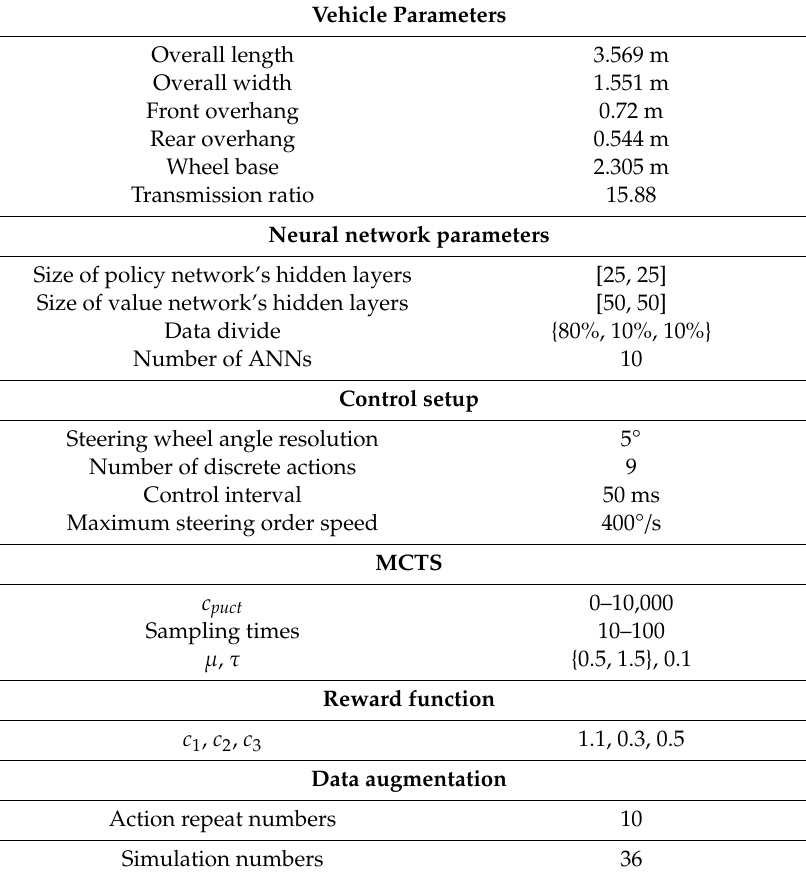
Table A1. Whole set of